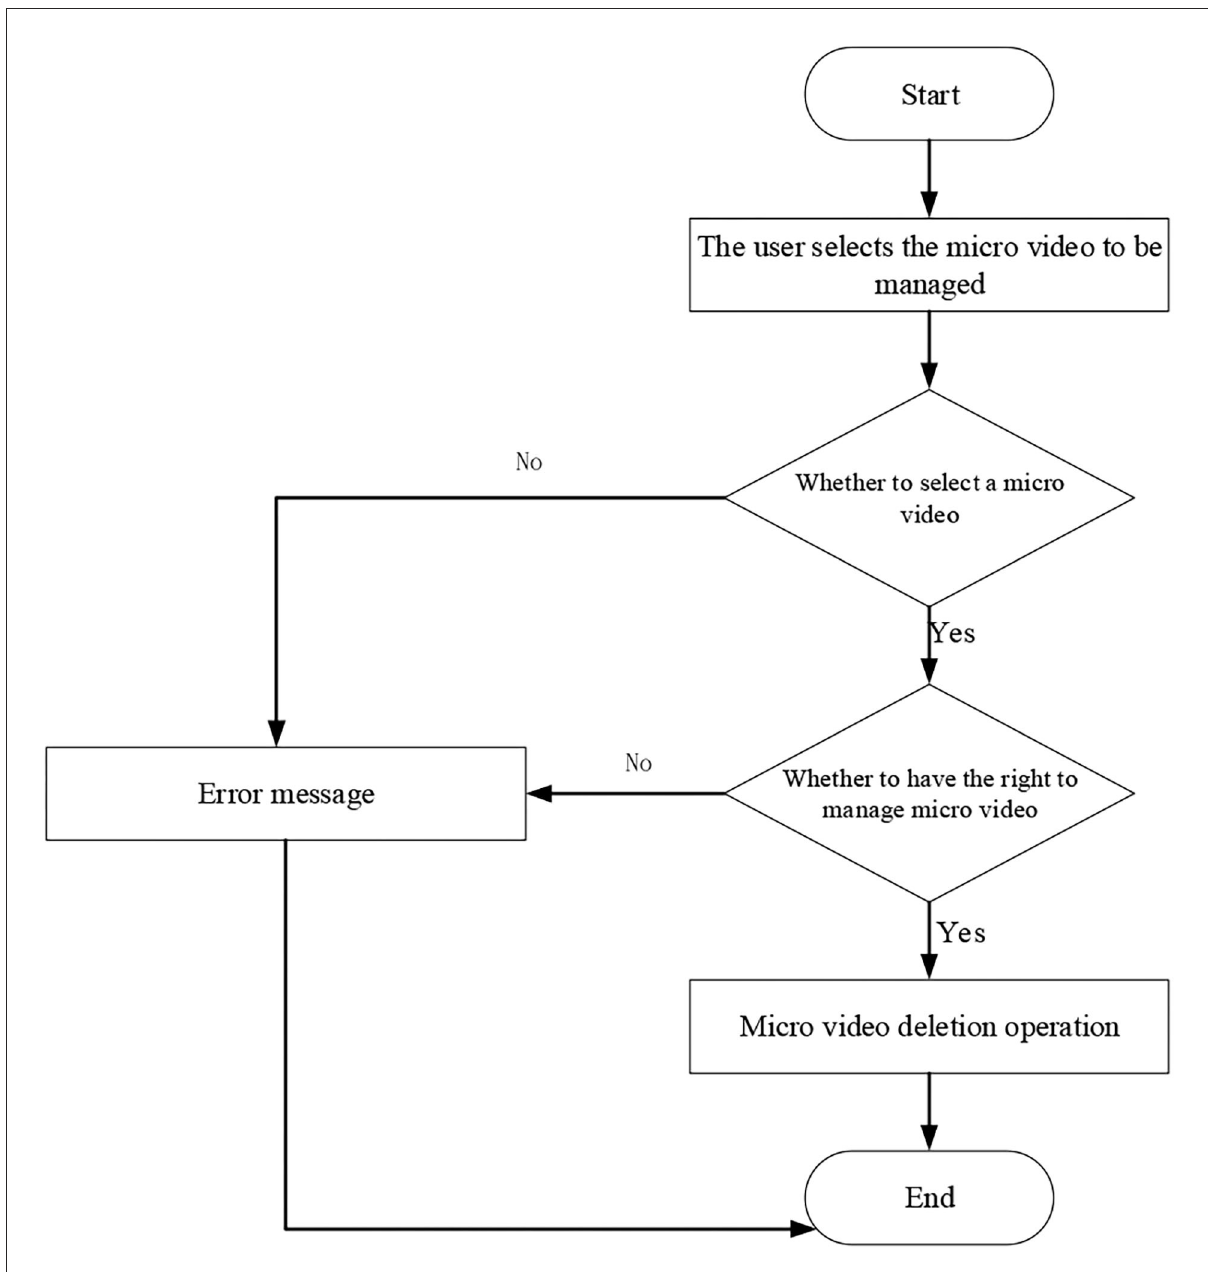
FIGURE12 Flowchart of micro-video